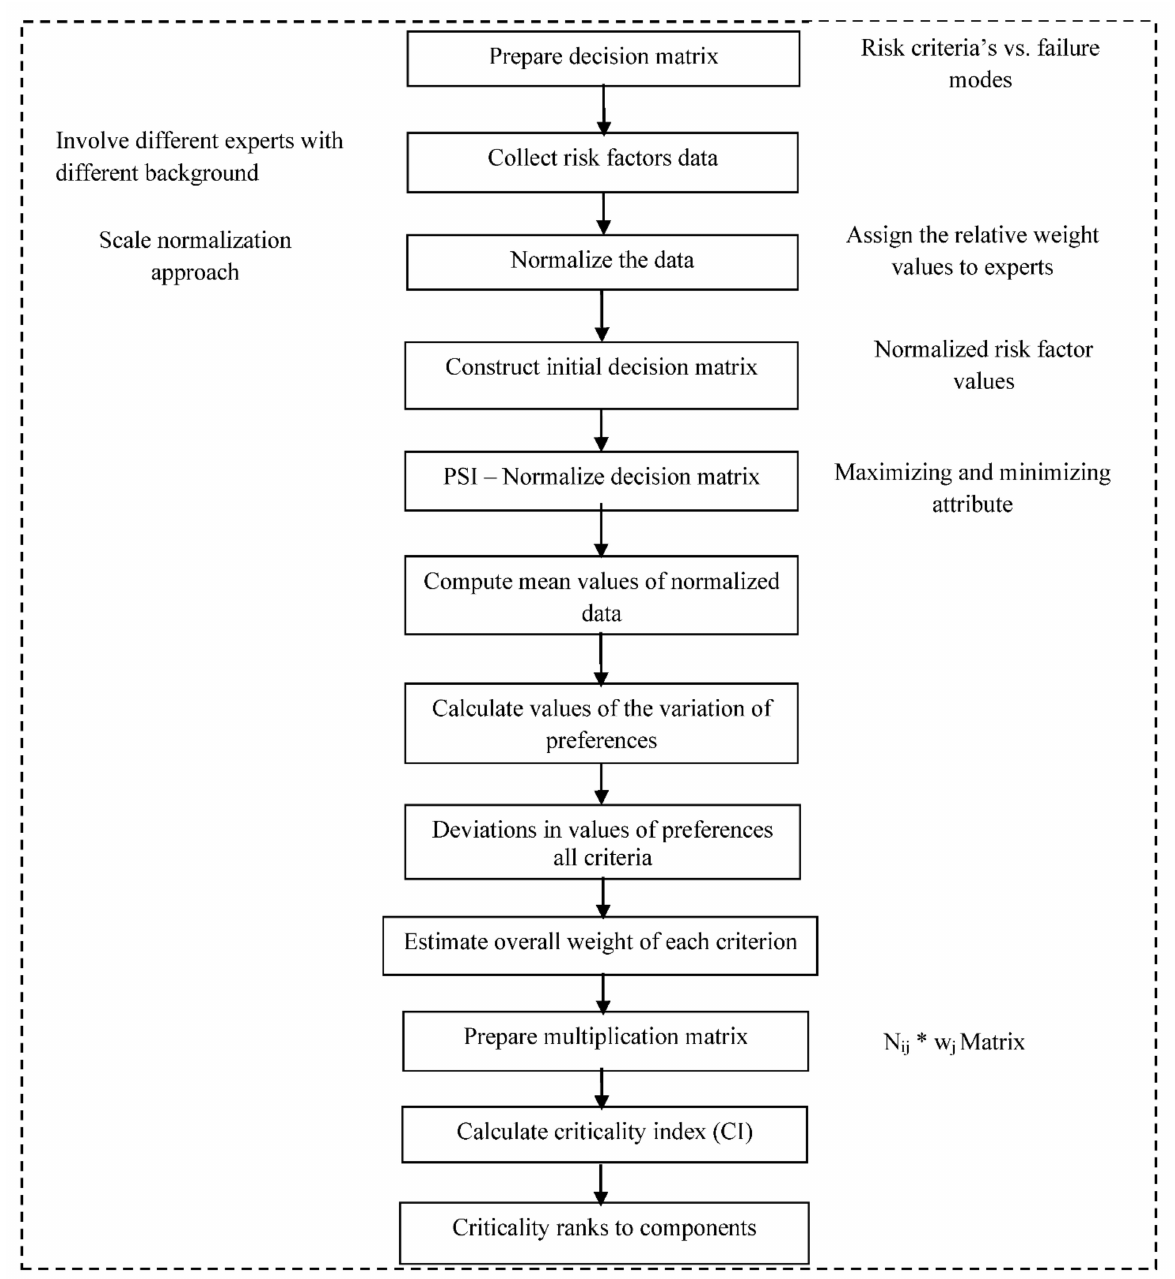
Figure 1. Framework of the integrated ExJ-PSI